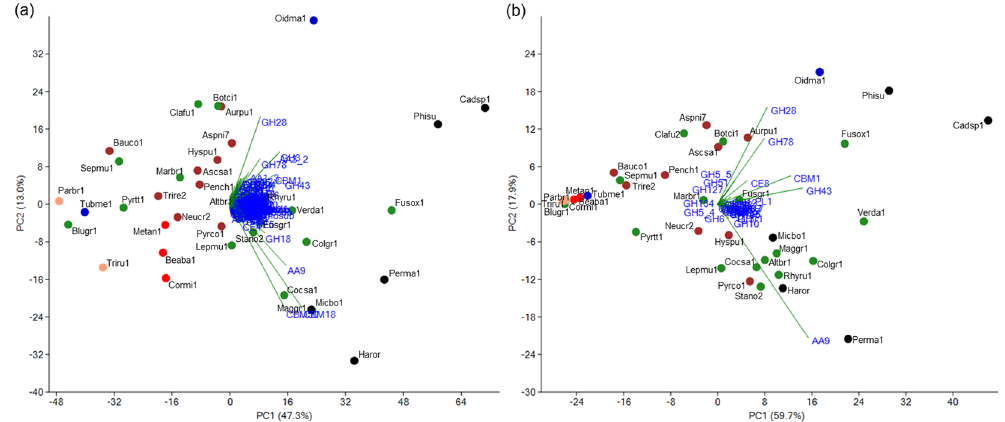
Figure 5. Principal component analysis (PCA) of carbohydrate active enzymes (CAZymes) and plant cell wall degrading enzymes (PCWDEs) of Cadophora sp., Periconia macrospinosa , and 35 other ascomycetes including three further DSE species. ( a ) PCA based on CAZyme copynumbers. PC1 accounts for 47.3% of the variation and PC2 for 13%. ( b ) PCA based on gene copy numbers of plant cell wall degrading families. PC1 accounts for 59.7% of the variation and PC2 for 17.9%. The different fungal lifestyles are labelled in red (ap/e; animal pathogens/endophytes?), brown (sap; saprotrophs), green (plp; plant pathogens), black (dse, dark septate endophytes), blue (myc; mycorrhizal fungi), or pink (ap; animal pathogen). For complete species names and further information see Supplementary Table